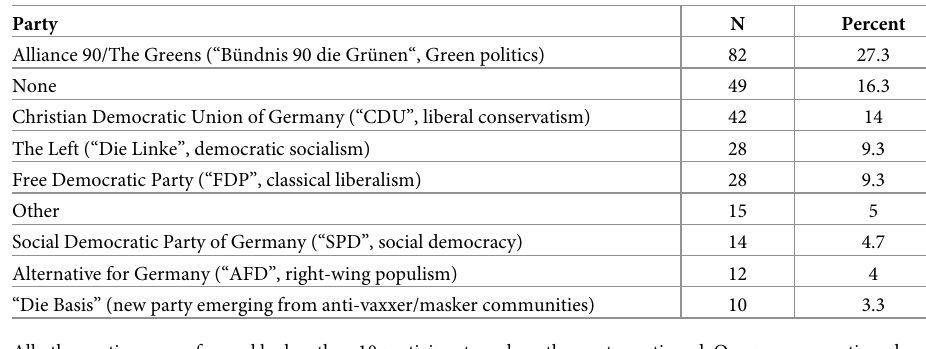
Table 1. Party Preference Study